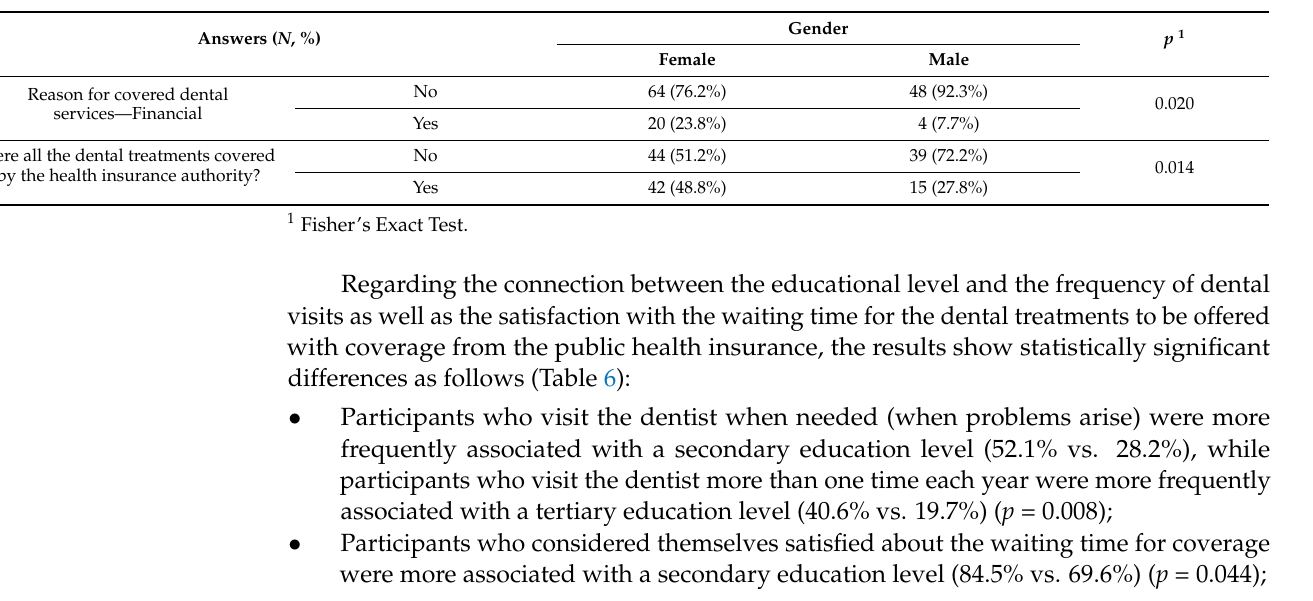
Table 5. Distribution of the participants according to gender and certain answers in the survey.